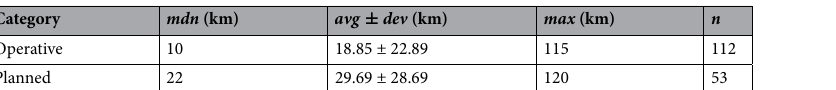
Category mdn (km) avg ± dev (km) max (km)